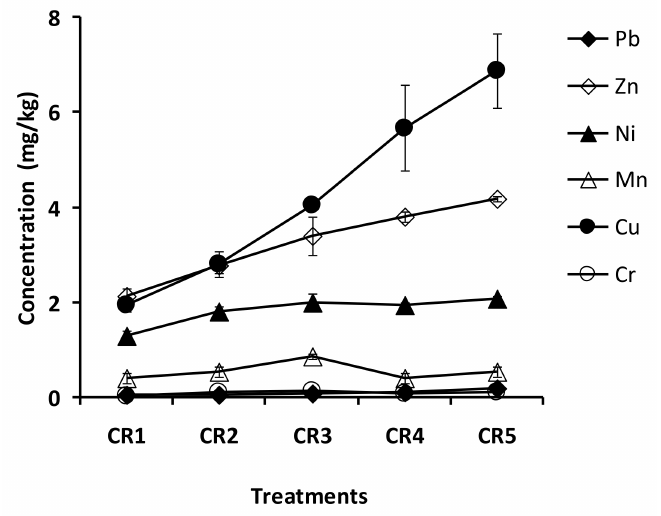
Figure 5. Heavy metal concentrations in roots of C. cajan . Bars represent means ± standard deviation ( n = 3). UR is an uncontaminated rhizosphere and CR 1 to CR5 represent contaminated rhizosphere with POS from 1 to 5% w / w ).